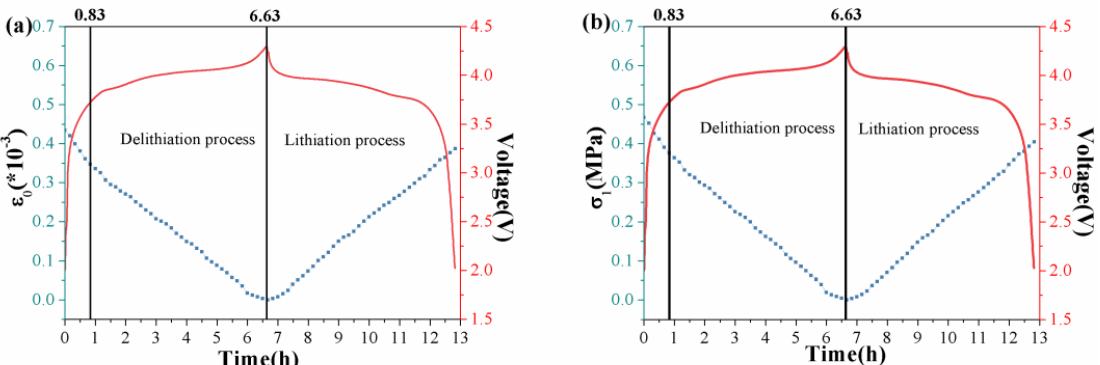
Figure 7. ( a ) Contraction strain–voltage and ( b ) stress–voltage evolution during the 3rd cycle of the LiMn 2 O 4 composite electrode at 0.1